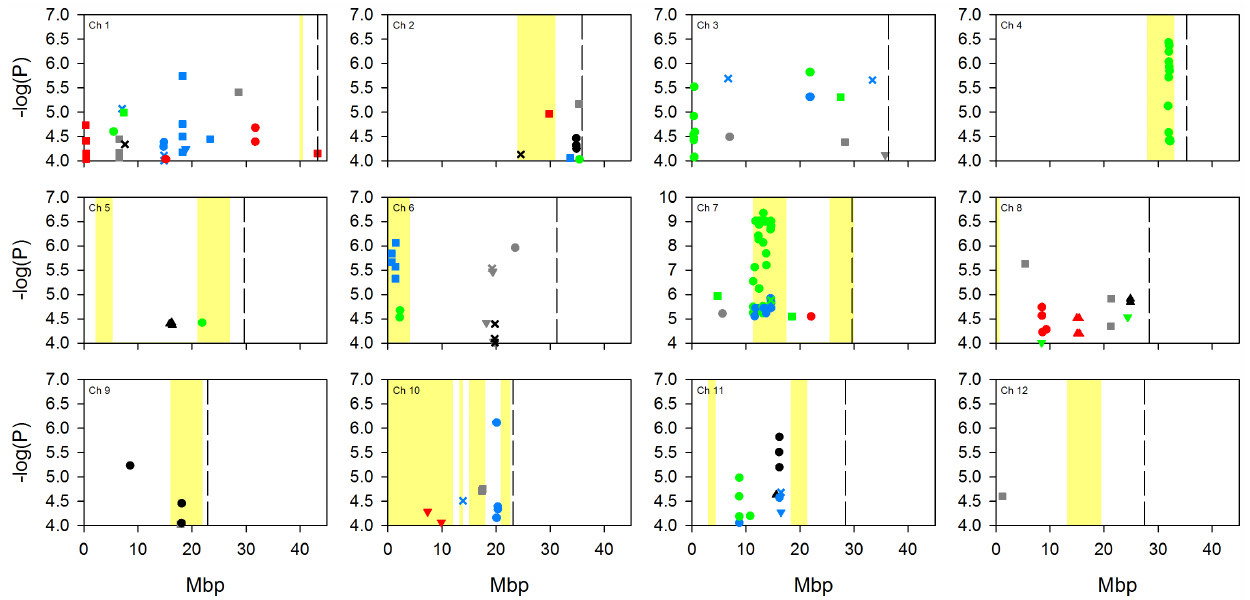
Figure 4. GWA mapping of zinc concentration at the five field sites across the 12 rice chromosomes. Data points represent SNPs significantly associated (p , 0.0001) with the trait and which have a MAF . 5%. Significant SNPs from different experiments are displayed with different coloured symbols: 2006 Arkansas are red, 2007 Arkansas are black, 2009 Texas are blue, Faridpur are green, and Qiyang are grey. Analyses of the combined subpopulation groups and separate subpopulations are represented by different symbols: combined analysis=X, aus =circle, indica =square, tropical japonica =triangle, temperate japonica =inverted triangle. Yellow highlighted bars indicate regions of mapped QTLs for grain zinc concentration (15–17, 20, 21, 22). Dotted lines indicate chromosome ends.